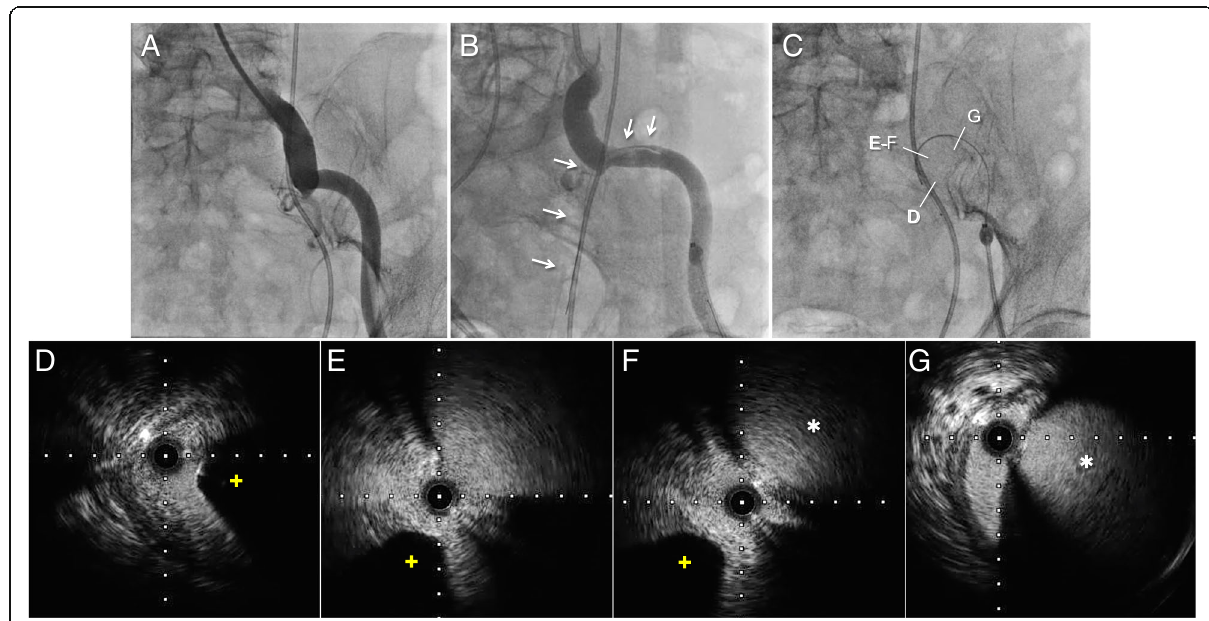
Fig. 2 The endovascular procedure and the findings of intravascular ultrasound. a , Baseline angiography did not show the blood flow into the left ureter from the left iliac arteries. b and c A 0.014-in. guidewire was advanced into the left ureter along the stent from the subintimal lumen of the external iliac artery ( white arrows ). The anatomical findings were evaluated by intravascular ultrasound (IVUS). d IVUS detected the stent with an acoustic shadow ( yellow plus signs ) in the left ureter. e – g IVUS detected the communication between the ureter and subintimal lumen of the EIA ( white asterisks denote true lumen of the left external iliac artery )